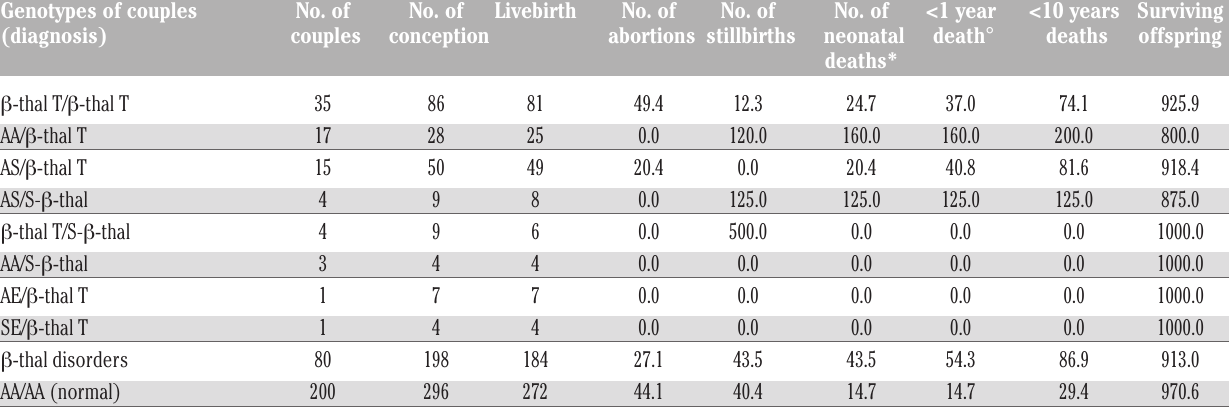
Table 2. Comparison of reproductive history (figures are 1000 live-births) of carrier couples with and without different b -thalassemia disorders. Genotypes of